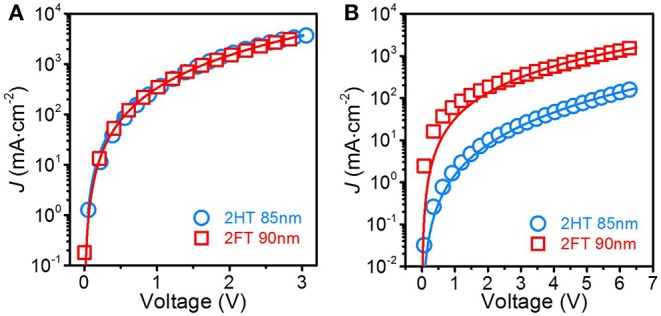
Dark current density-voltage characteristics for (A) electron-only (ITO/Al/active layer/Al) and (B) hole-only (ITO/MoO3/active layer/MoO3/Ag) diodes with optimized PBDT[2X]T:PC71BM active layers.